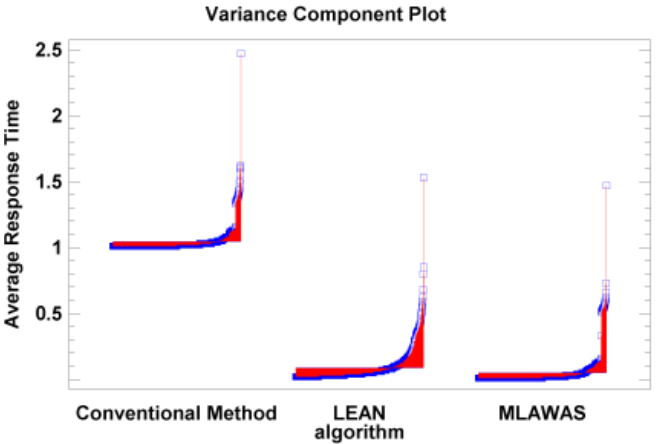
Figure 15. Average Response Time of Workload with Round-Trip and Migration